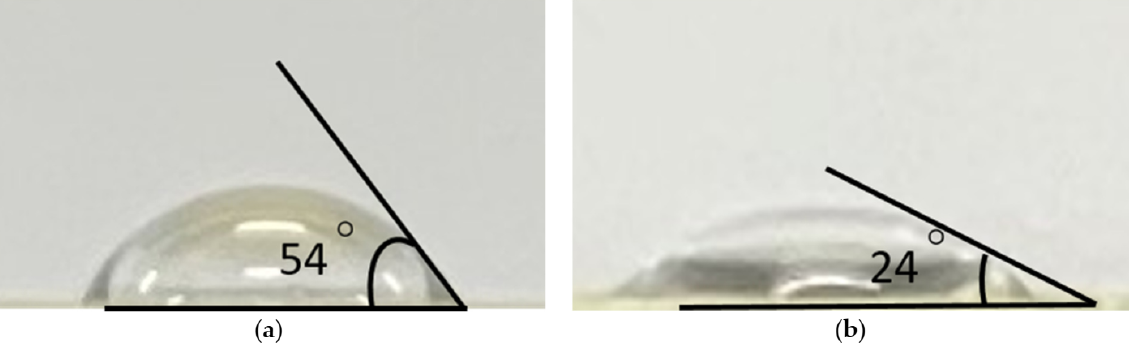
Figure 1. Contact angle test diagram: ( a ) PET without UV irradiation; ( b ) PET after UV irradiation for 15